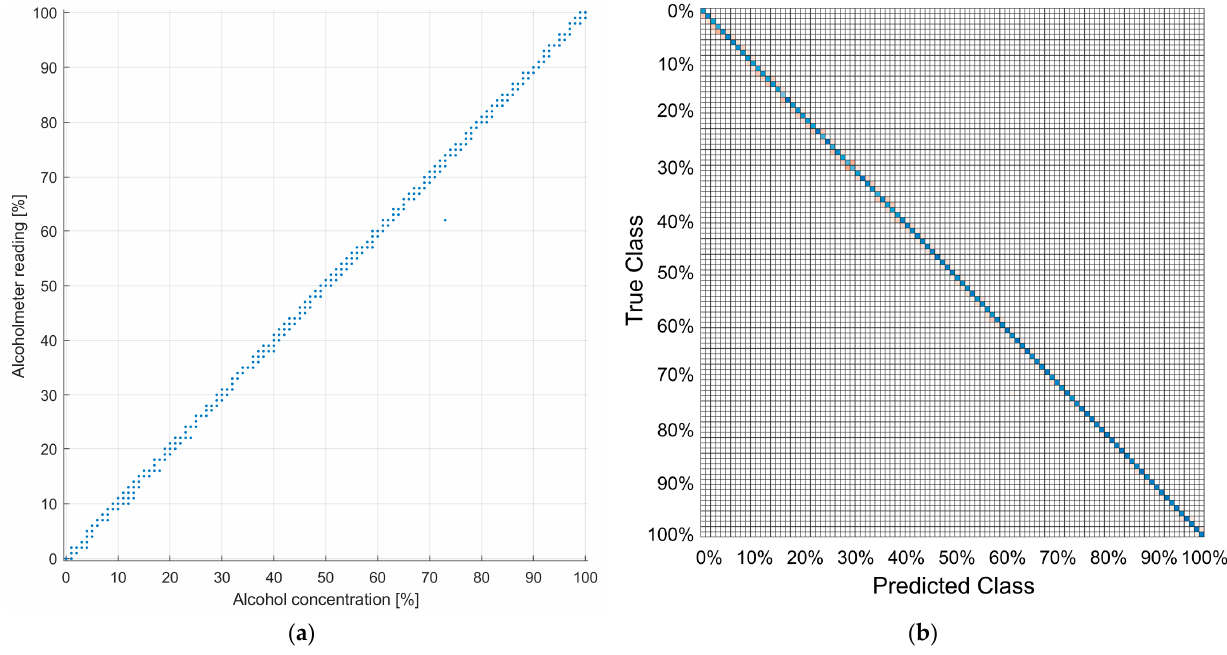
Figure 12. Classification results: ( a ) scatter plot of alcoholmeter readings versus ground truth alcohol concentration; ( b ) confusion matrix plot—blue fields represent true positives (where prediction made by model matches ground truth) and red fields represent misclassified samples.